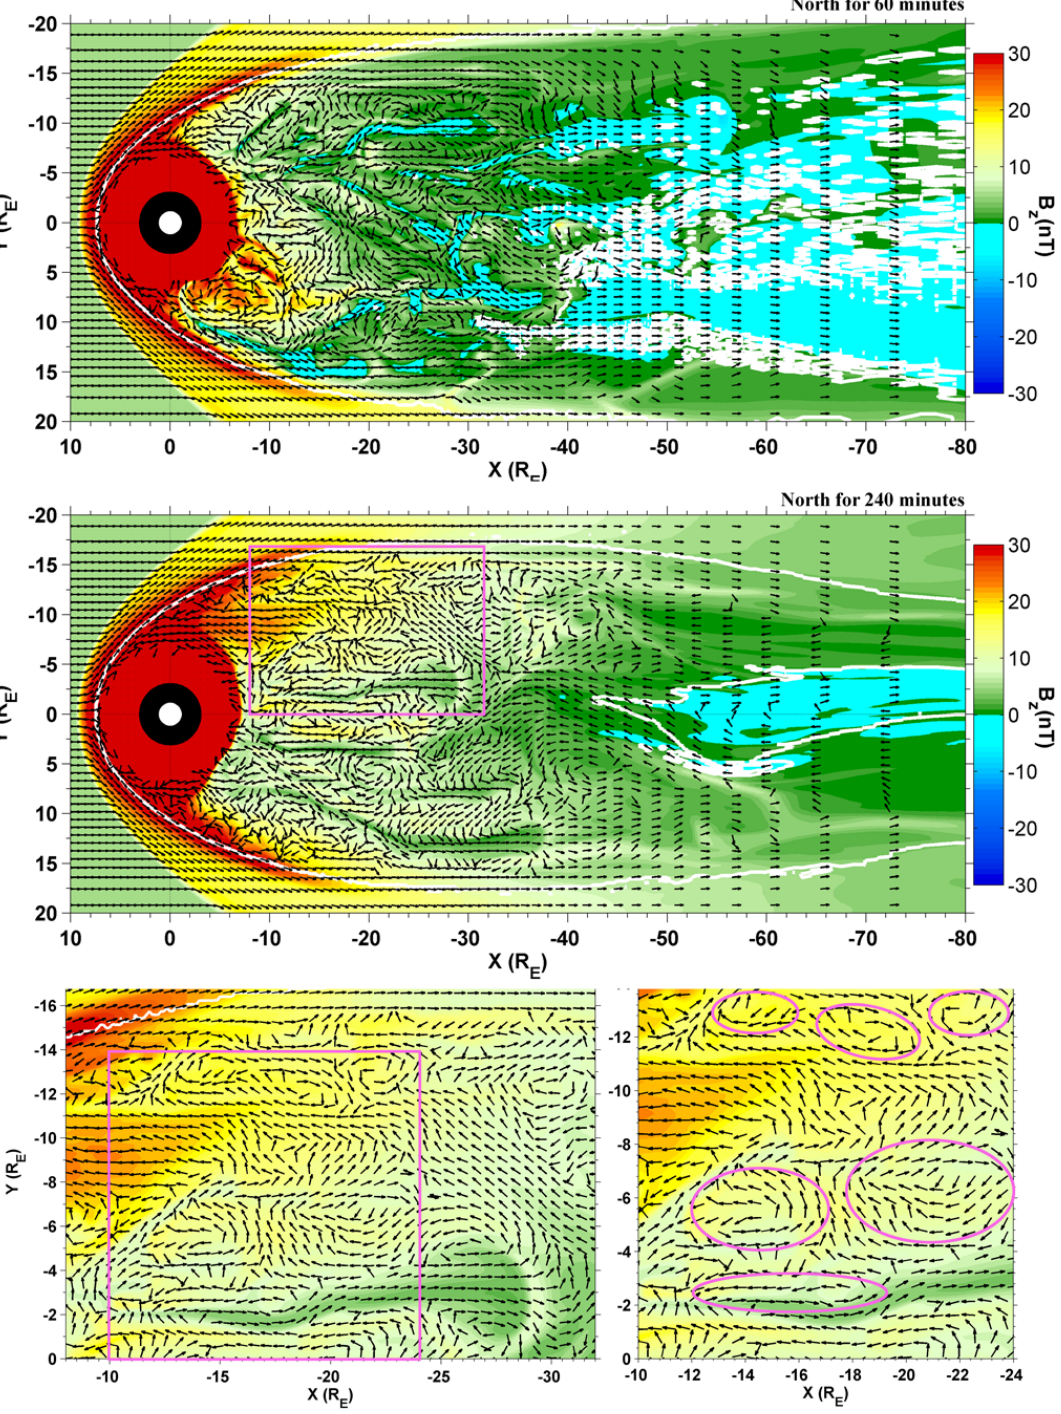
Fig. 2. MHD solutions in the equatorial plane at two times. The top panel is at T N +60min, the second panel from the top is at T N +240min. The arrows are unit vectors of flow velocity in the plane and color contours show the north-south component of the magnetic field. The white isocontours give the locations of the last closed field lines. The region enclosed by a magenta rectangle in the second panel is expanded in the bottom left panel to reveal nested vortices. A rectangular enclosed region in the bottom left panel is further expanded in the bottom right